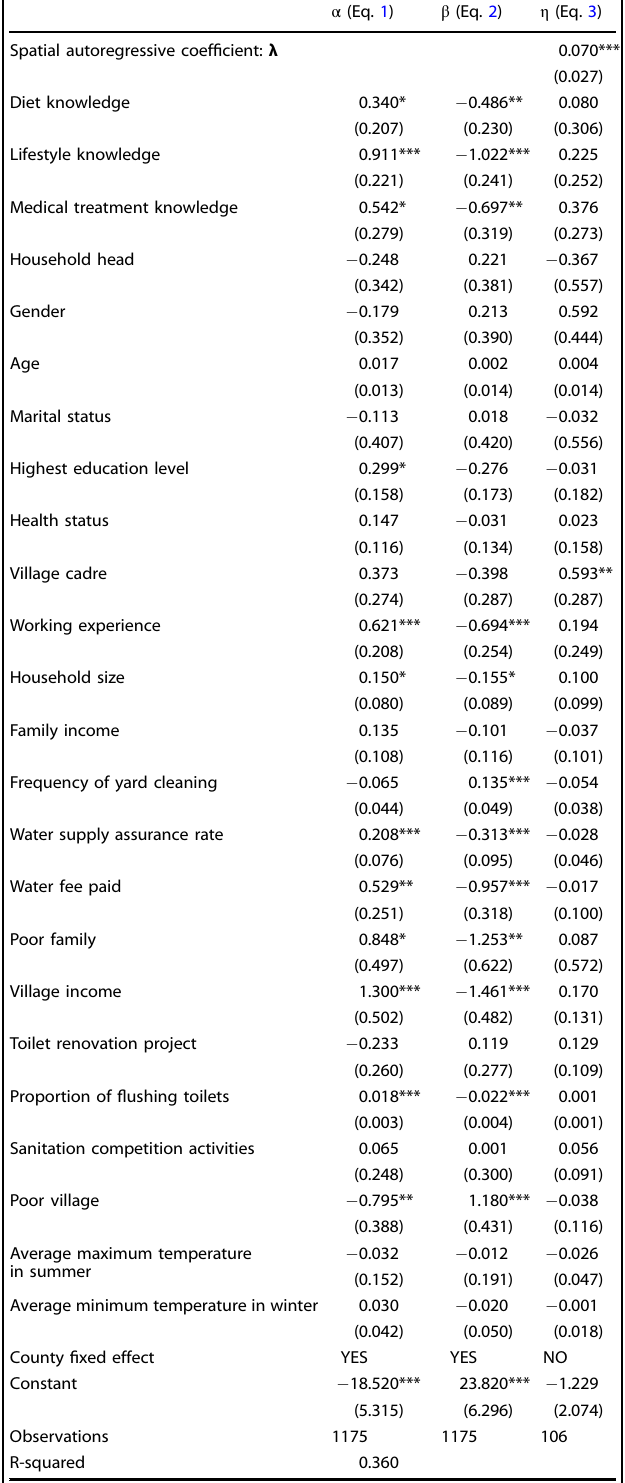
Table 1. Regression coef fi cient results in Logit, Duration Analysis, and Spatial Autoregressive